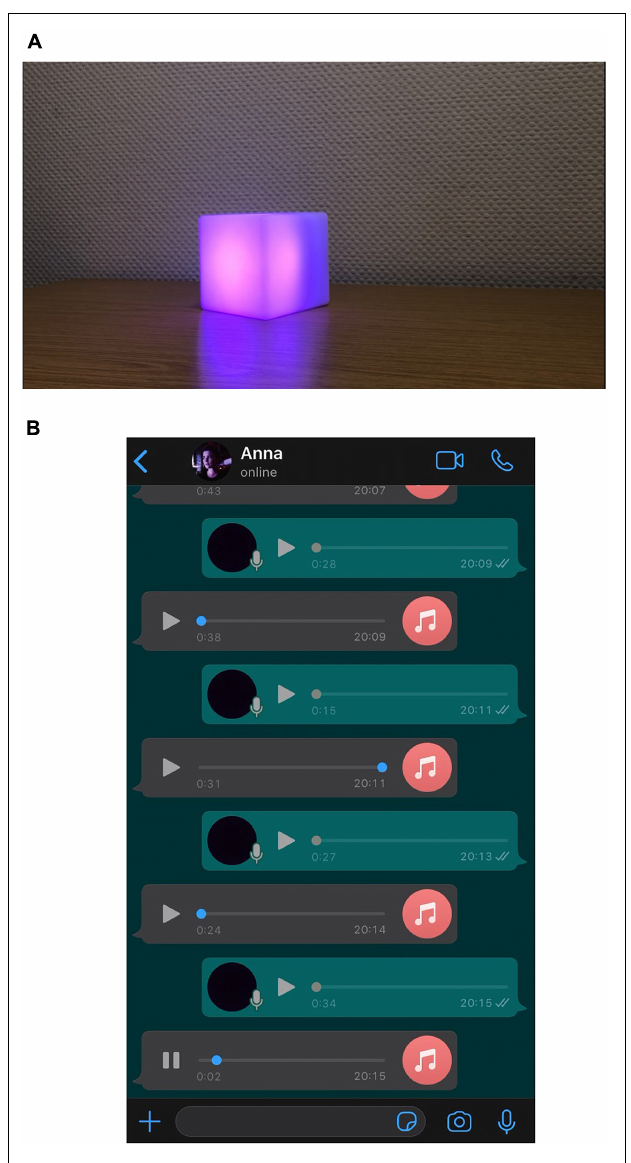
FIGURE 1 | Stimulus material of the ontological class conditions. (A) Voice assistant. (B) Computer-mediated